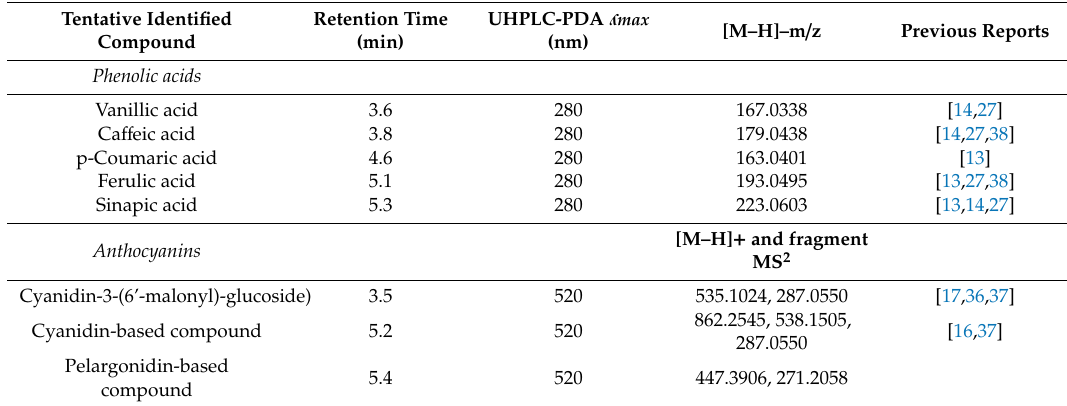
Table 2. Characteristics of phenolic acids and anthocyanins detected in the garlic samples. UHPLC: ultra-high performance liquid chromatography with photodiode array detection.